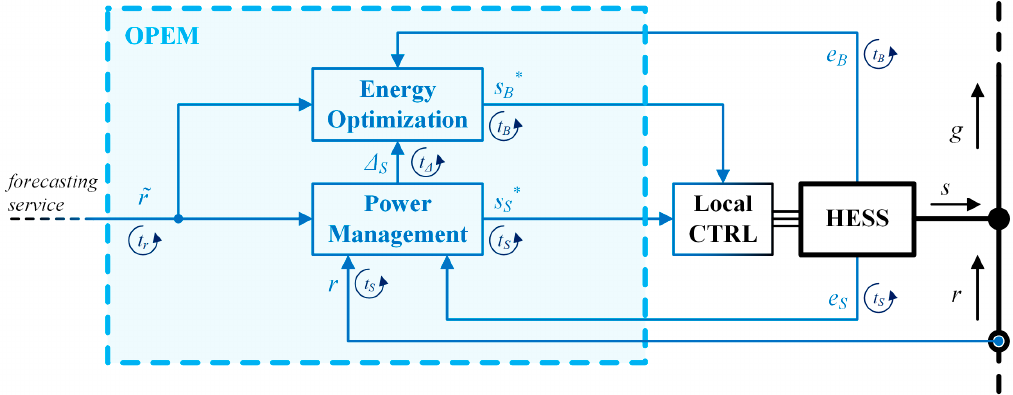
Figure 2. T he overall block control scheme of the proposed OPEM.